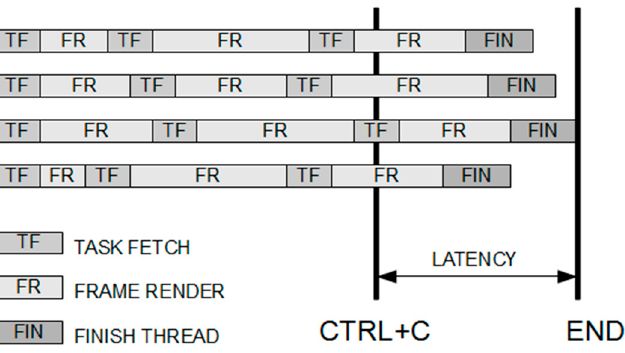
Figure 4. Timeframe and stopping latency for distributed